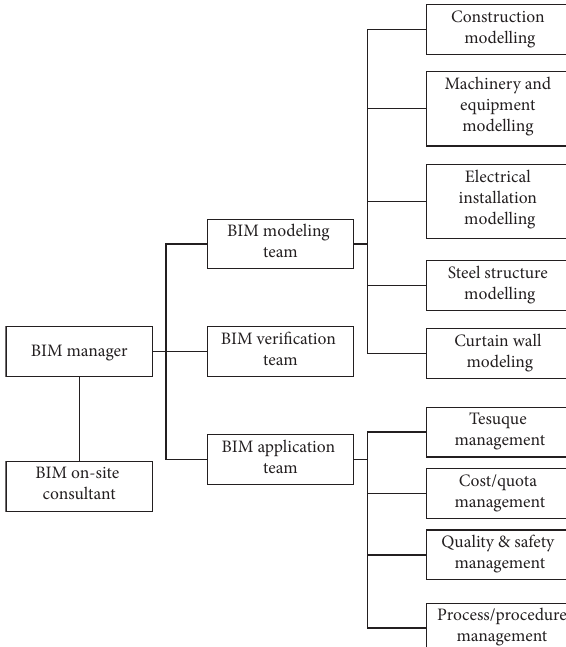
Figure 8: The structure of a BIM management team.